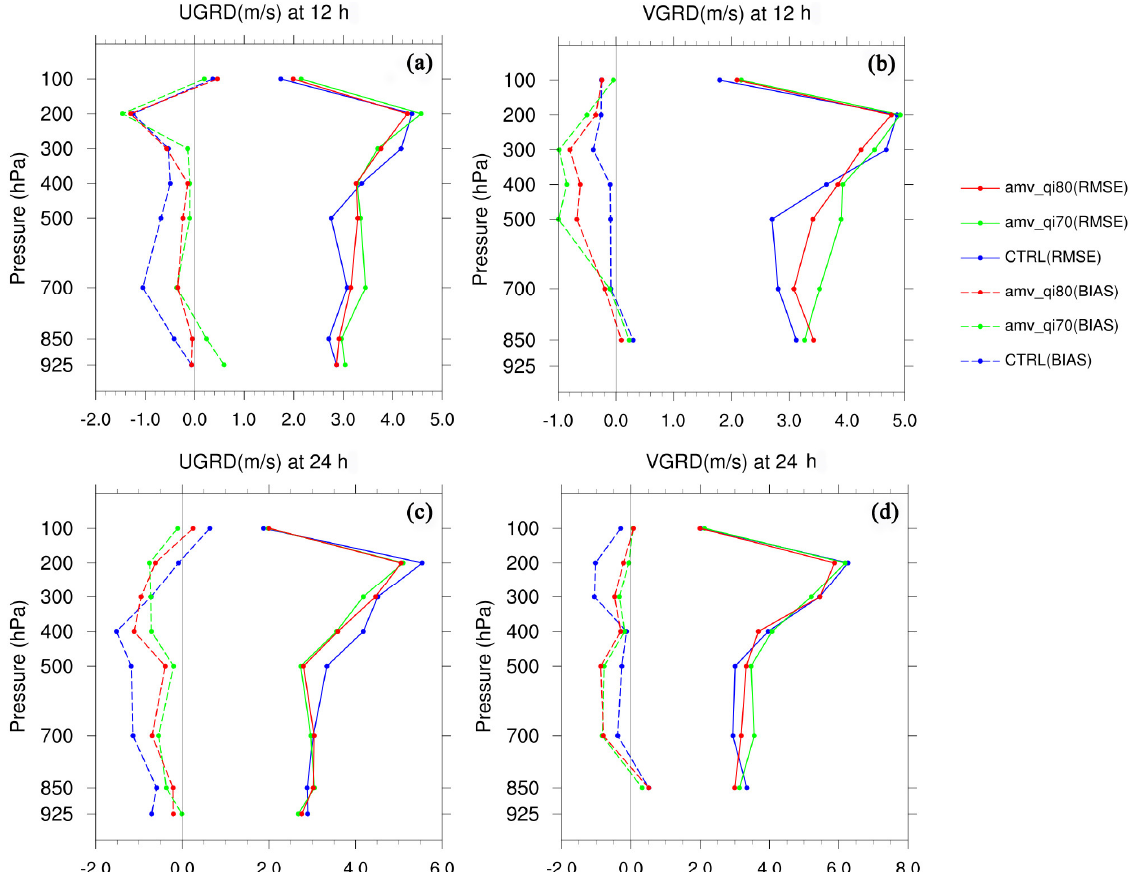
Figure 7. The bias and RMSE of the forecast U (UGRD) and V (VGRD) wind averaged over the 3 km domain from the experiments of the CTRL, amv_qi70 and amv_qi80. ( a , c ) represent the values for U wind at 12 h and 24 h of the forecast, respectively; ( b , d ) represent the values for the corresponding V wind.